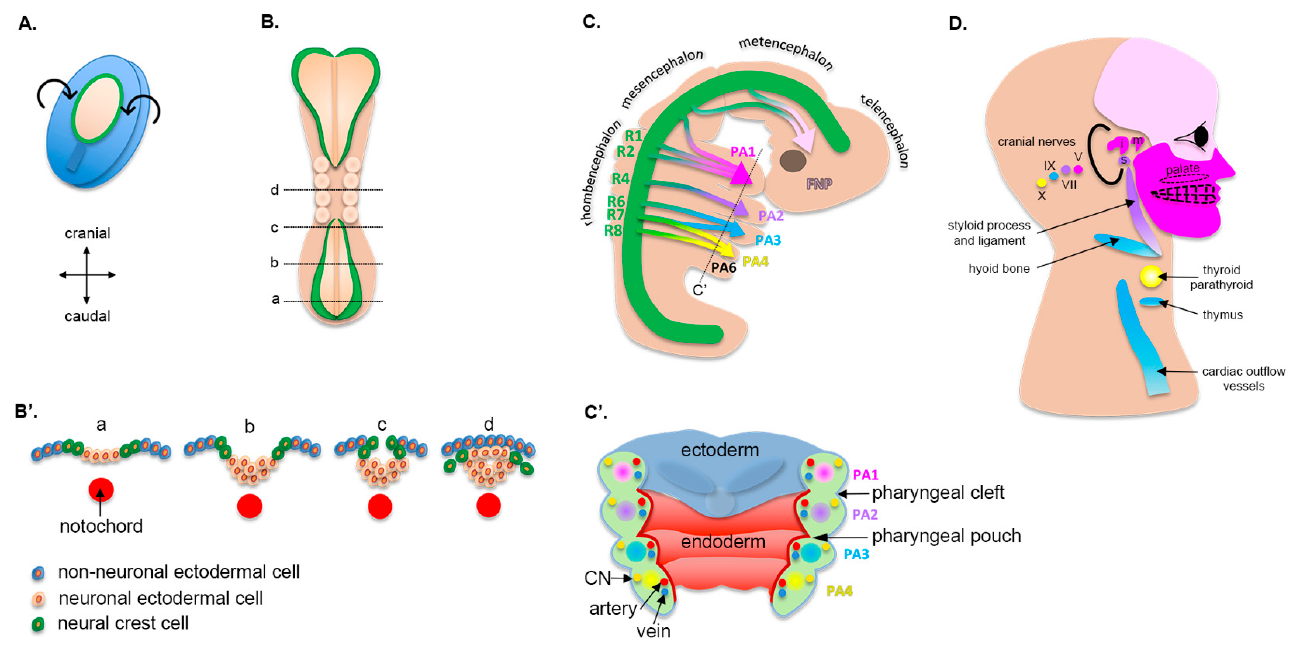
Figure 1. Morphogenesis of pharyngeal arches and their derivatives. ( A ) Dorsal view of a human embryo at approximately 16 d EGA. The neural plate is being specified (pale area) and will undergo dorsal folding. ( B ) Dorsal view of a human embryo at about 22 d EGA. Note that the neural folds (green color) start to fuse in the midline. Transverse views at different levels of the embryo are shown in ( B (cid:48) ). ( C ) Lateral view of a human embryo at approximately 32 d EGA. The neural tube (green) is specified in different rhombomeres (R1 to R8), all of which (except R3 and R5) will contribute to pharyngeal arches. ( C (cid:48) ) Longitudinal view of the pharyngeal arches. Each pharyngeal arch is